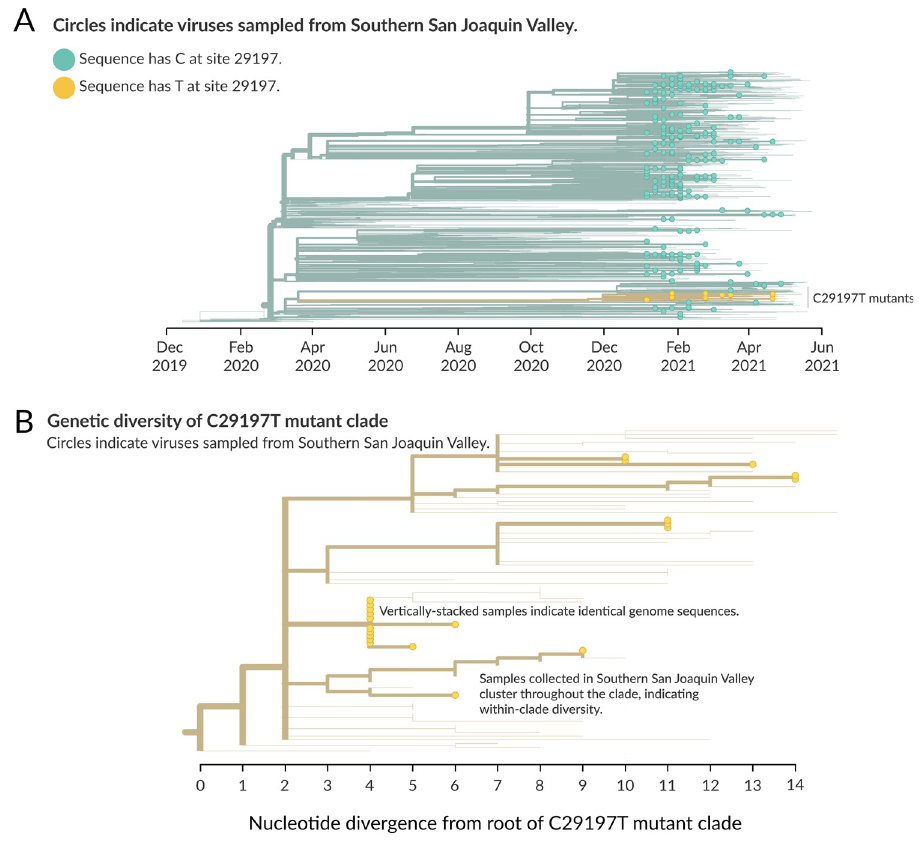
Fig 2. Timing and diversity of 29197T-variant circulation in Southern San Joaquin Valley. (A) Phylogenetic tree of 2519 SARS-CoV-2 genomes colored by the nucleotide found at position 29197 in the genome, indexed per the Wuhan- Hu-1 reference strain (NCBI accession number MN908947). Nucleotide C at position 29197 denotes the wild-type, colored in teal. Nucleotide T at position 29197 denotes the mutation of interest, also referred to as C29197T mutants, highlighted in yellow. As in Fig 1, genomes generated as part of this study have leaves indicated with circles, while background sequences are shown only with branches. (B) Genetic divergence of the C29197T clade, which was made up of both B.1.1.222 variants and B.1.1.519 variants in February before being resolved in April as containing exclusively variants classified as B.1.1.519. Background sequences are indicated only by their branches, while sequences from Southern San Joaquin Valley are indicated with circles at the leaves, and wider